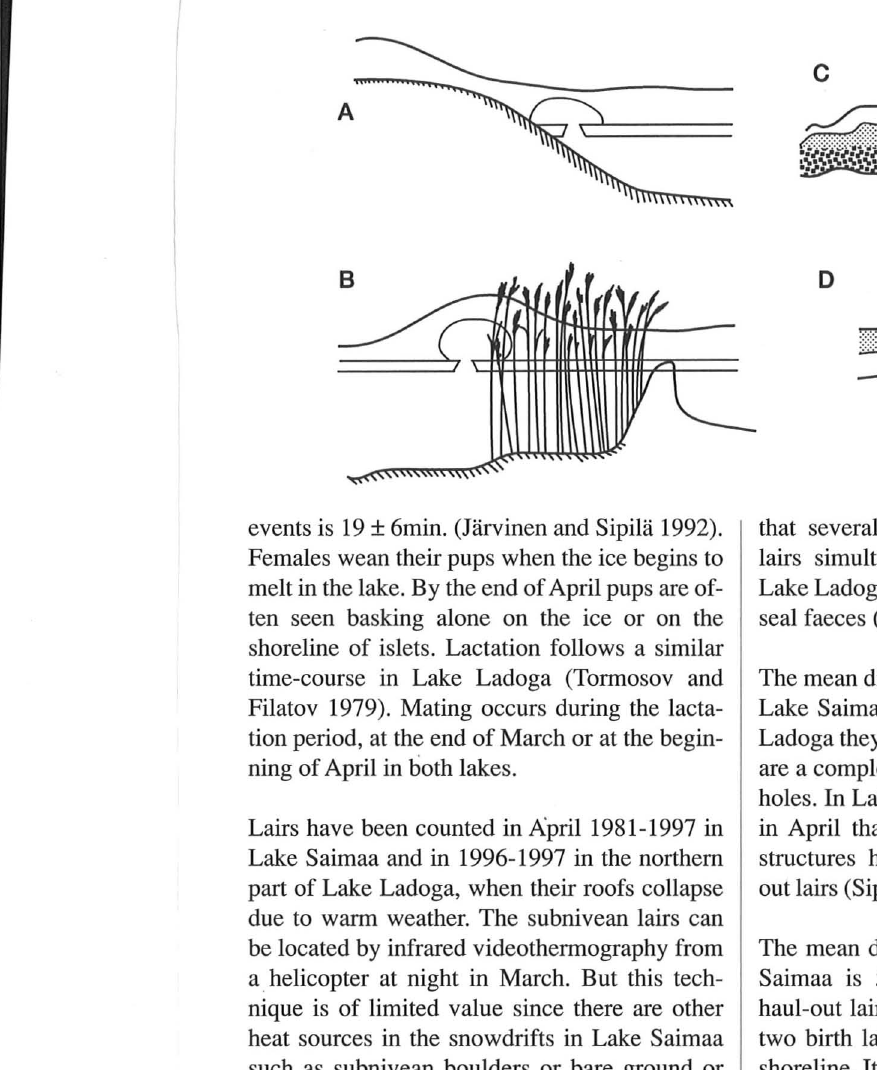
Fig.S Different ringed seals lair sites in Lake Saimaa, Lake Ladoga and the Arctic